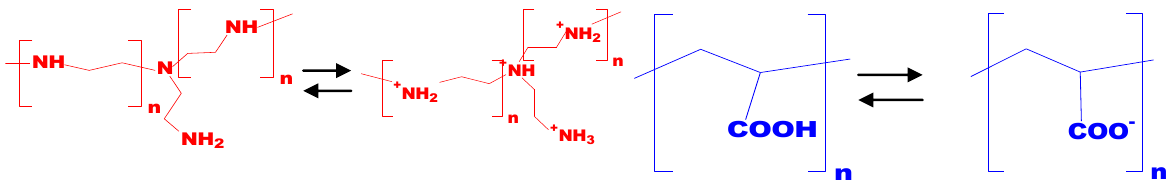
Figure 2. Structural formulae and pH dependence of branched poly(etyhleneinmine) (PEI) and linear poly(acrylic acid)